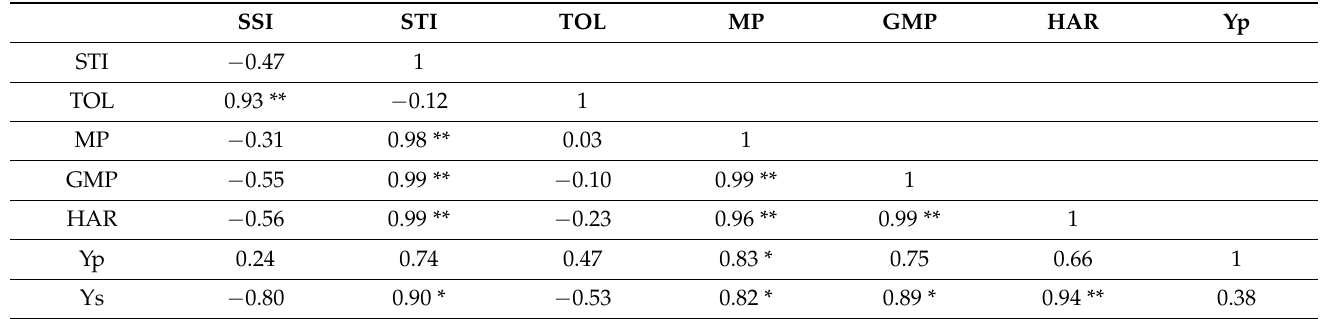
Table 7. Correlation coefficients between tolerance index and yield under stress conditions on the ear